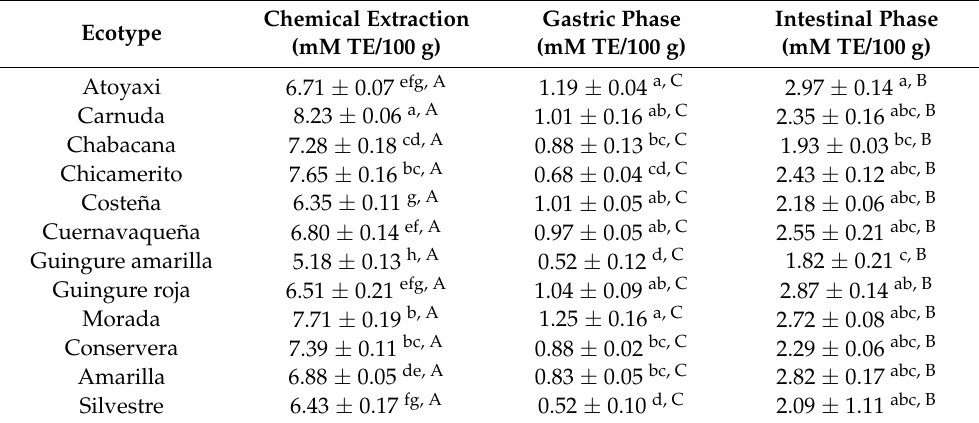
Table 7. Antioxidant capacity by ABTS of 12 ecotypes of S. purpurea L. before and after in vitro digestion.